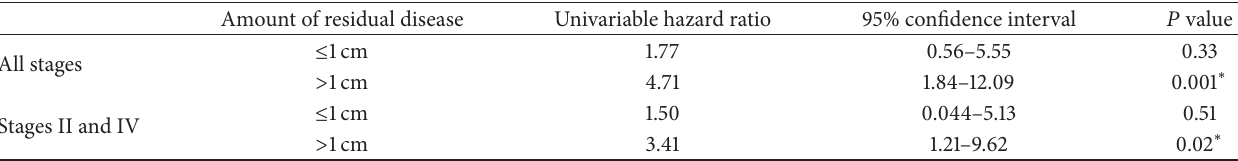
Age (1st compared to 3rd quartiles, 54.5 versus 73.5 years)